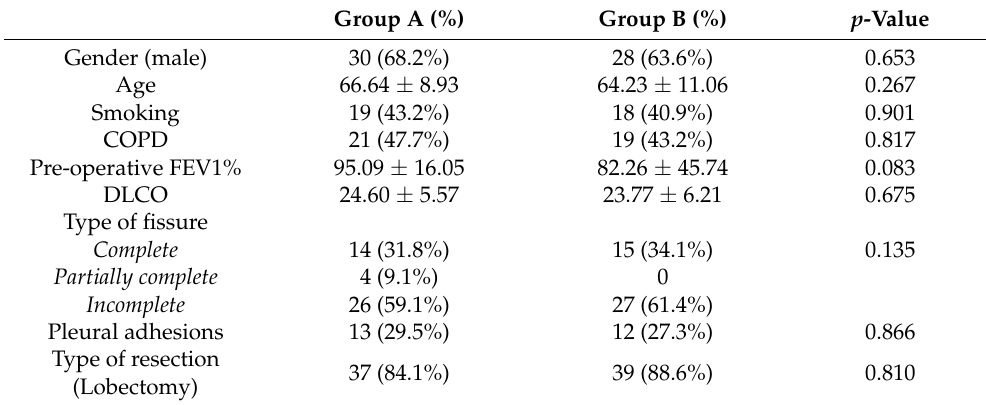
Table 1. Distribution of the main clinical and surgical characteristics between the Group A and Group B.